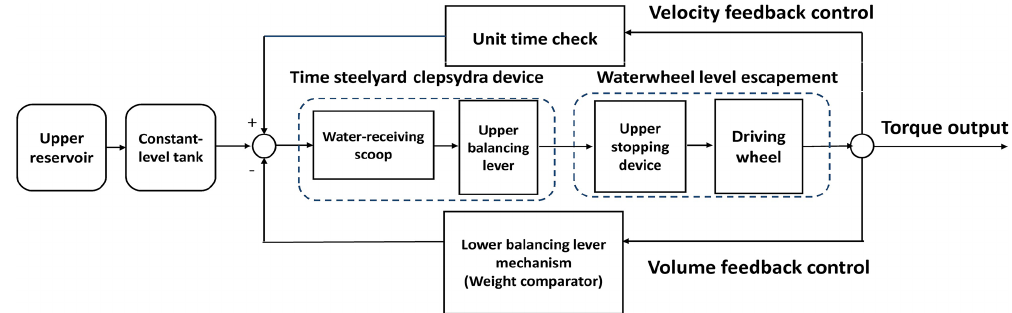
Figure 6. Kinematic model of Su Song’s waterwheel steelyard clepsydra (Lin, 2001).